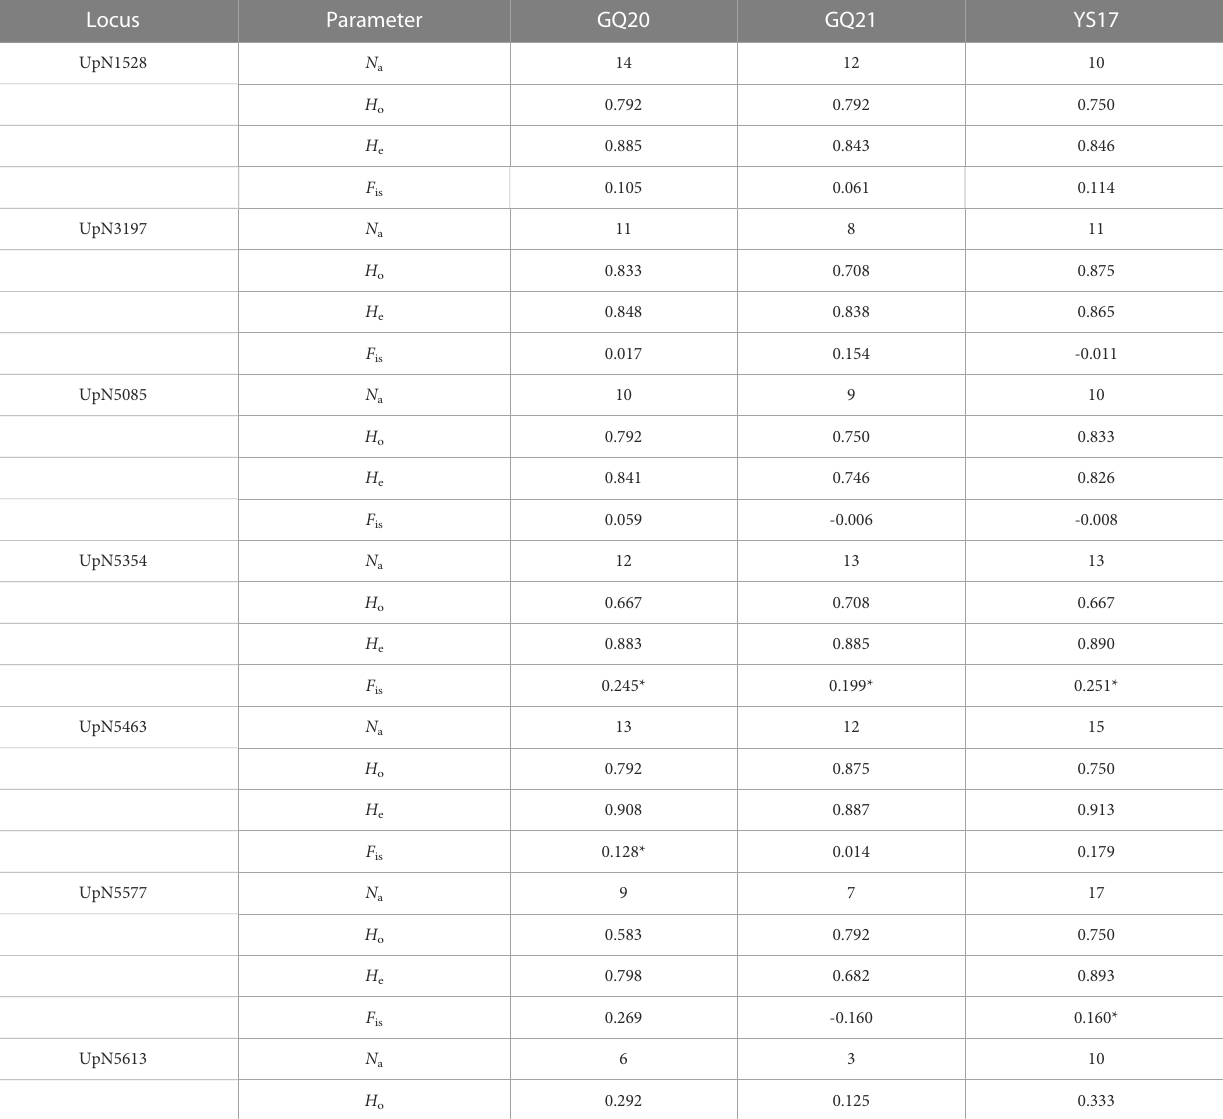
TABLE 3 Genetic diversity of native Undaria pinnati fi da populations from southern China at 10 microsatellite loci.